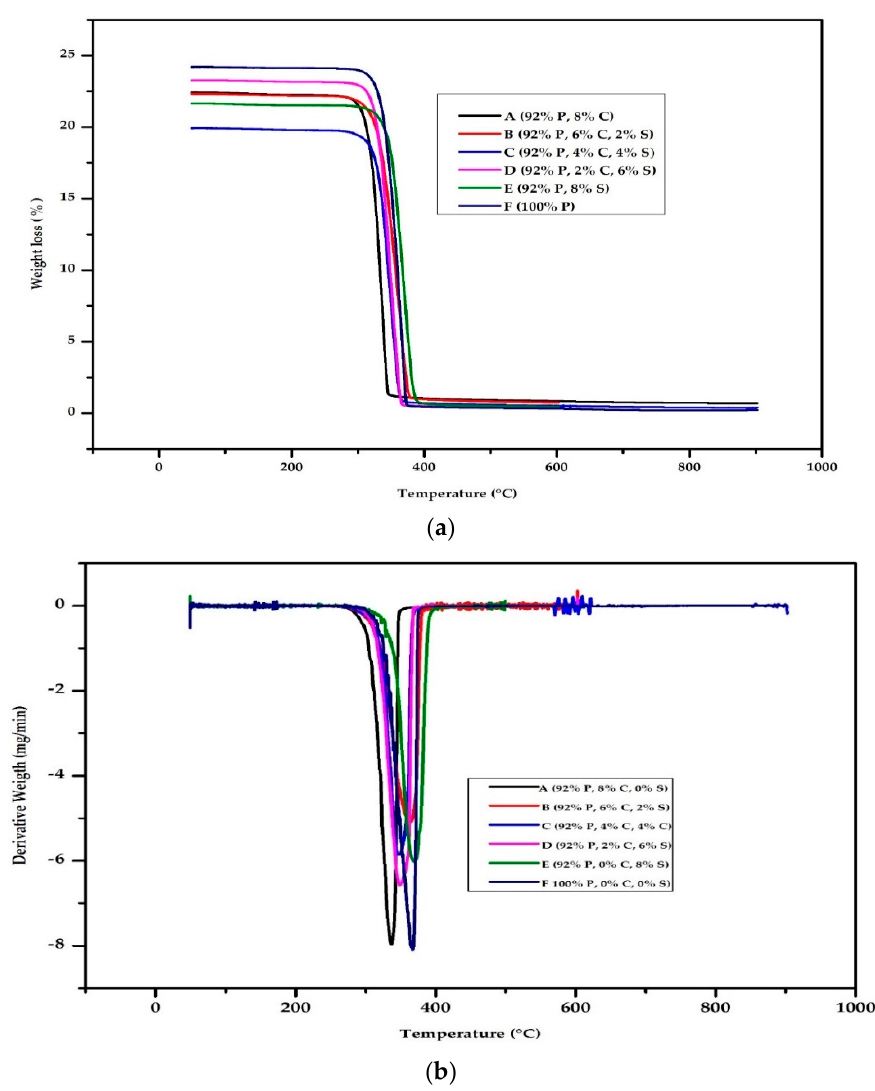
Figure 4. ( a ) Thermogravimetry analysis (TGA) result of samples A—92% polylactic acid (P)/8%